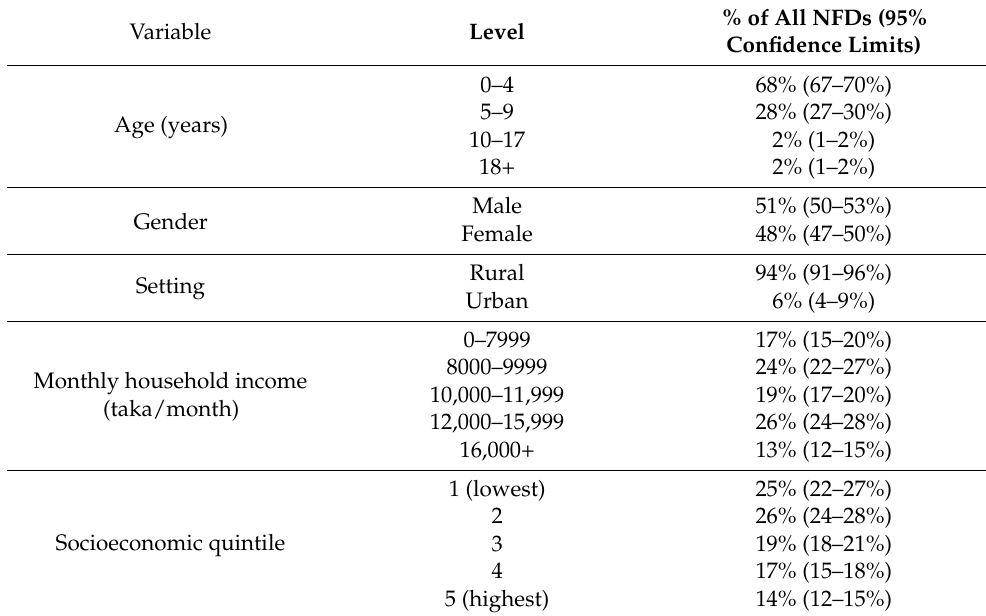
Table 1. Socio-demographic characteristics of people reporting non-fatal drownings